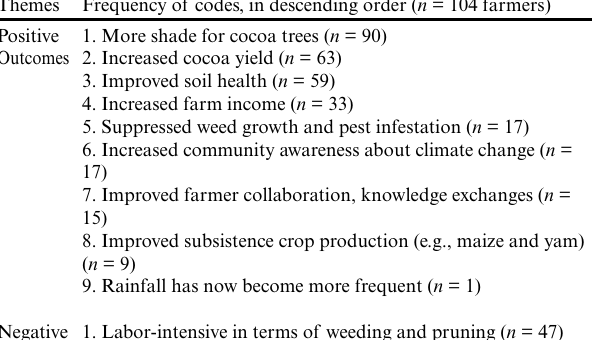
Table 3 . Farmer-identified positive and negative outcomes of agrobiodiversity interventions. Presented are the top outcomes from the introduction of agroforestry practices into cocoa